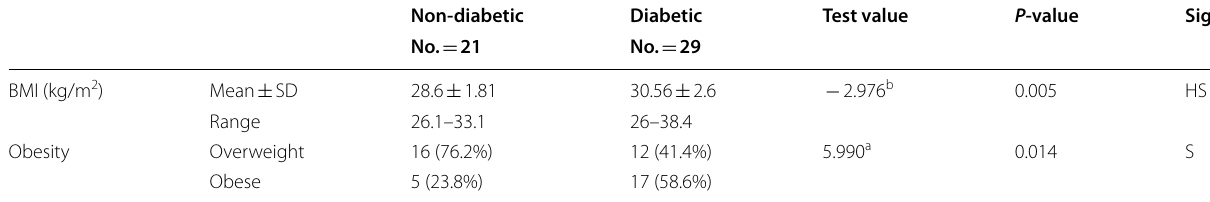
Table 6 Comparison between diabetic and non-diabetic patients regarding obesity and BMI